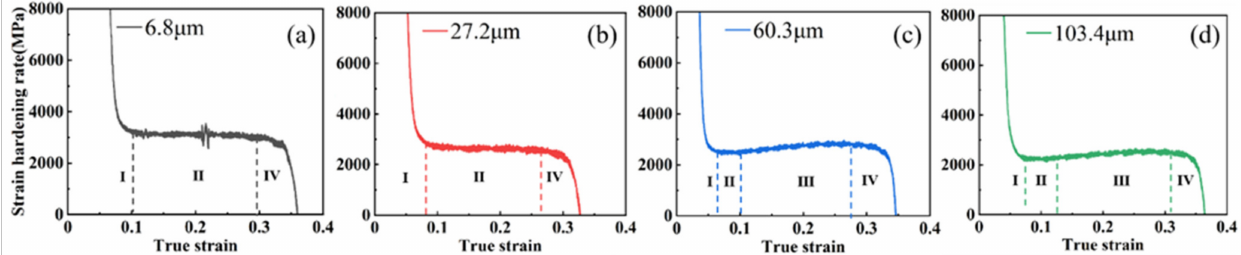
Figure 5. Work-hardening rate curves for each grain size samples at 20% reduction: ( a ) 6.8 µ m; ( b ) 27.2 µ m; ( c ) 60.3 µ m; ( d )103.4 µ m.